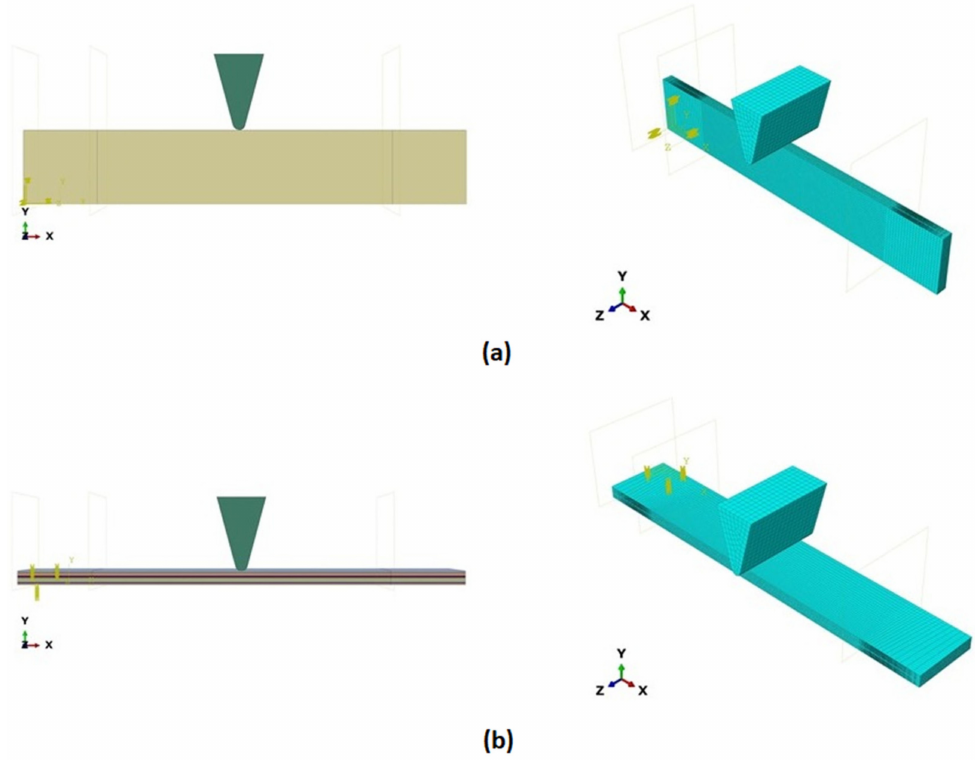
Figure 2. Model of the Charpy impact test; ( a ) edgewise impact direction, ( b ) flatwise impact